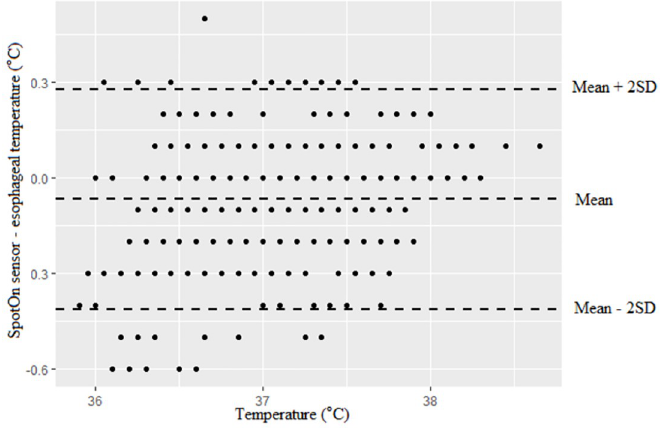
Fig 3. Bland–Altman analysis for SpotOn sensor versus esophageal temperature monitoring.